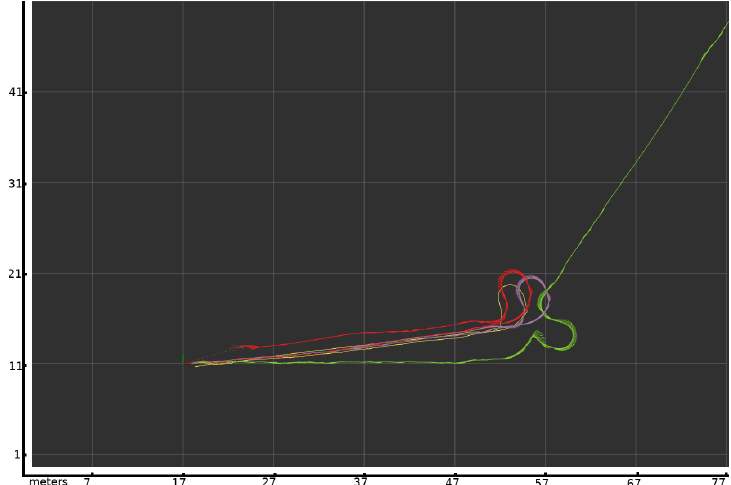
Figure 11. The same experiment as in Figure 4, but using the variable covariance presented in this paper. In the grid, each square represents 10 square meters. The green line is the position based only on odometry. The purple line is the position based on the laser scan matcher algorithm. The red line is the fusion using the variable covariance presented in this paper. The yellow line is the ground truth obtained using the Veldyne